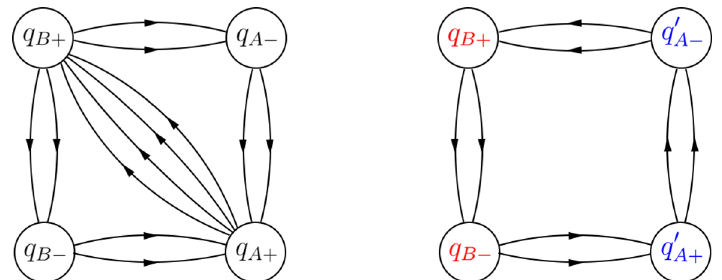
Figure 21 . The quiver diagrams for 5d SU(2) 0 theory. The left diagram is constructed according to the above analysis and the right diagram is obtained via a quiver mutation of q